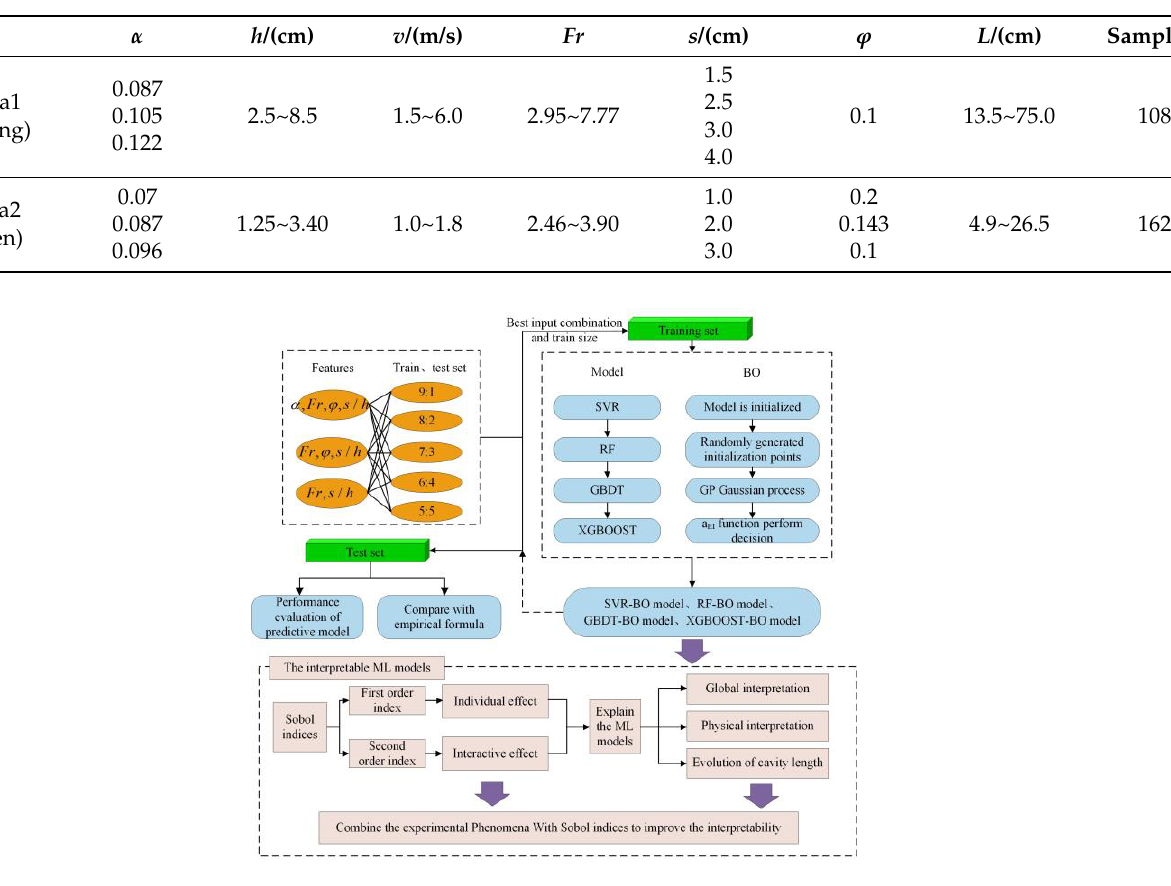
Figure 2. Construction of the ML models together with the interpreting analysis.